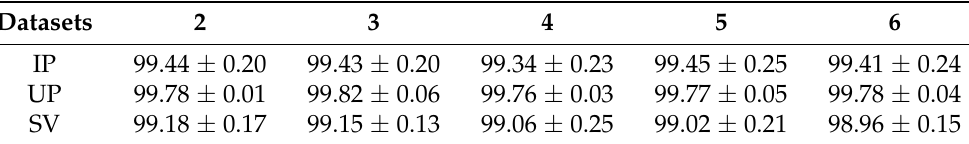
Table 5. OA (%) of PDCNet with different number of PDC layers in IP, UP, and SV datasets. Datasets